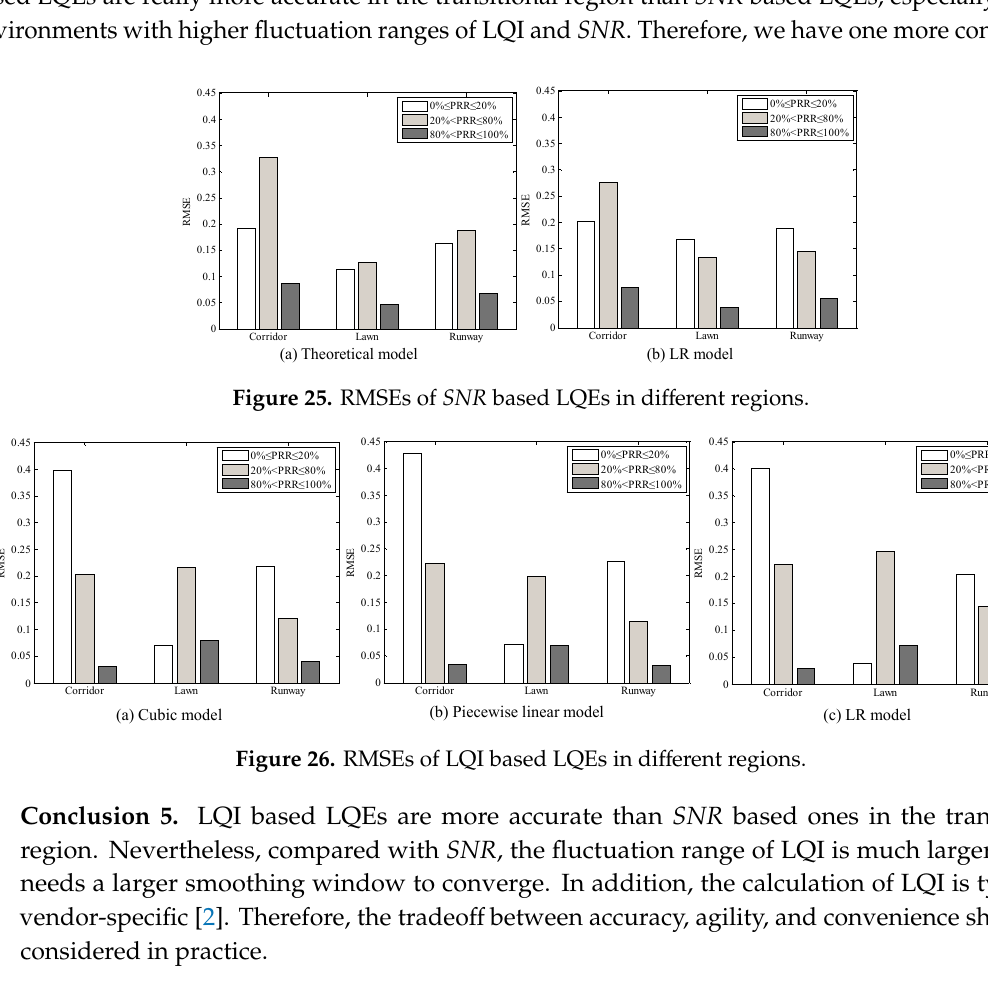
Figure 26. RMSEs of LQI based LQEs in different regions.